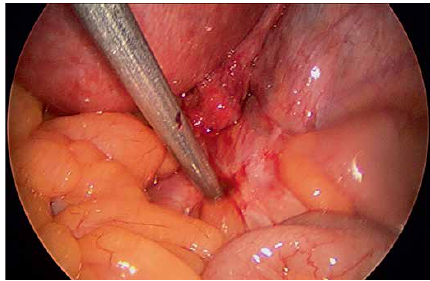
Figure 7: Laparoscopy revealed a dense 3 cm nodule over the right ureter at the pelvic brim involving the small bowel mesentery.